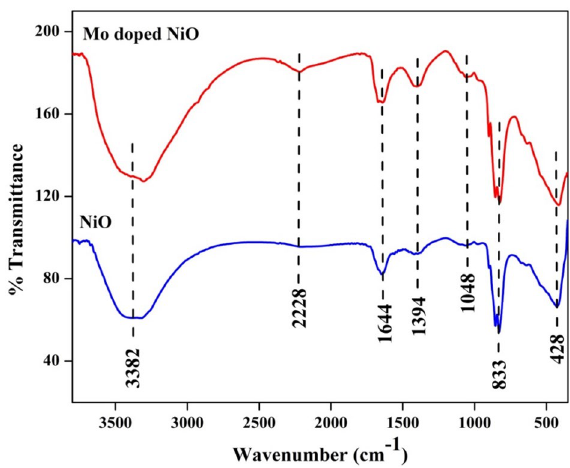
Figure 6. FT-IR analysis of NiO and Mo doped NiO